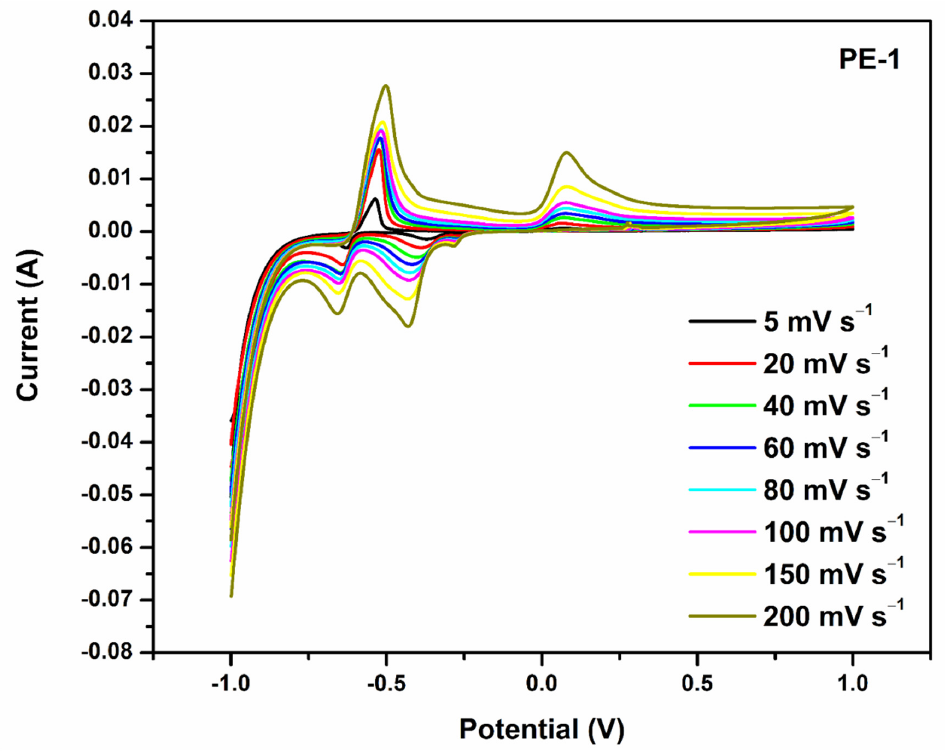
Figure 4. PVA − 20 wt% TEOS (PE − 1) cyclic voltammetric activity at numerous scan rates from 5 to 200 mV s − 1 .